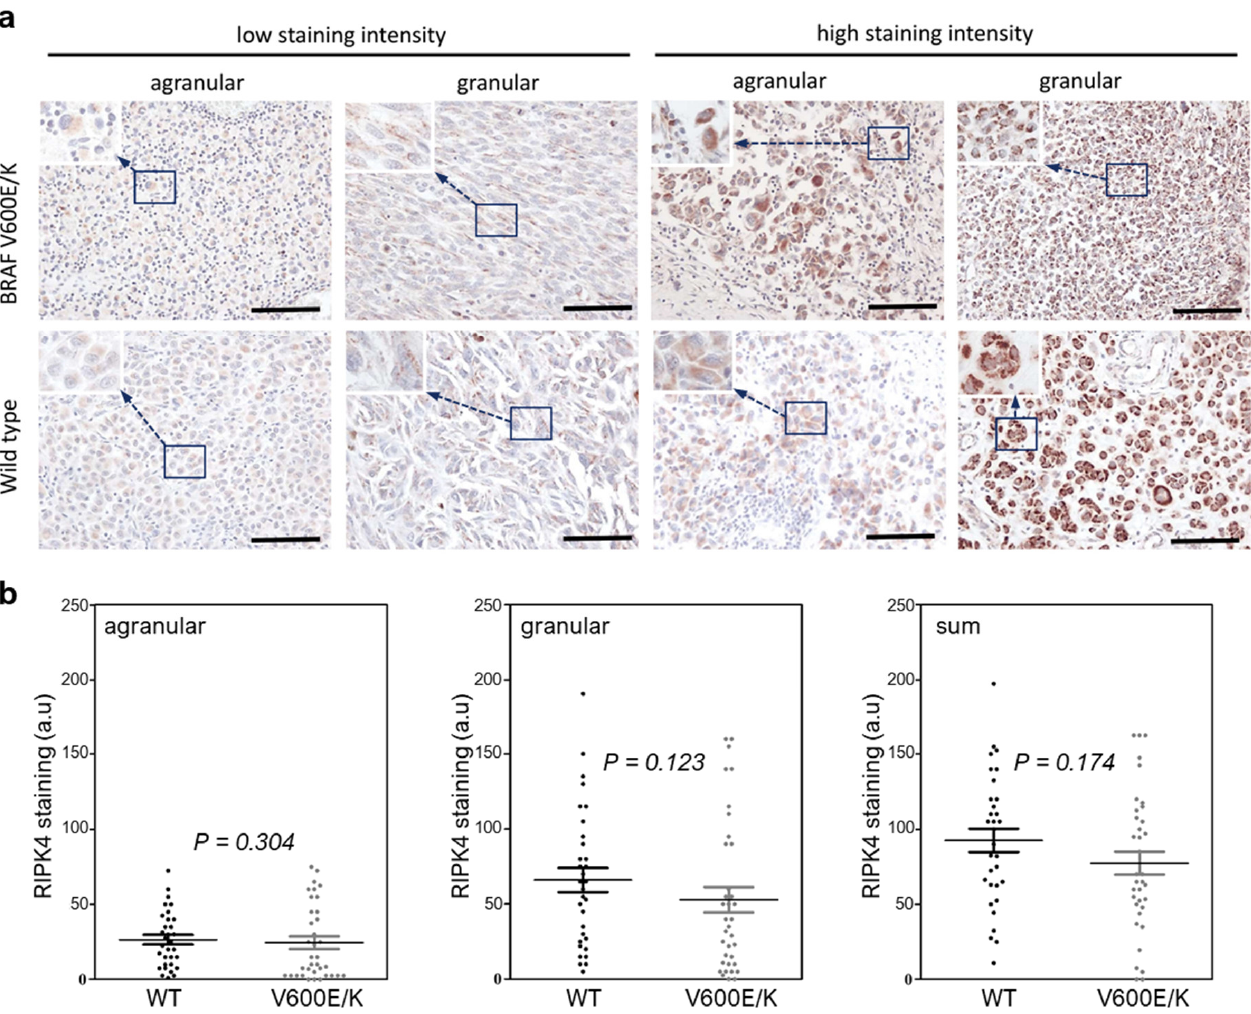
Figure 2. The BRAF mutation does not affect RIPK4 expression in metastatic melanoma. ( a ) Ex- pression of RIPK4 in wild-type and BRAF V600E metastatic melanomas with low and high (agranular and granular stain pattern). Original magnification: 400x, scale bar = 100 µm. ( b ) Quantification of RIPK4 in melanoma specimens. The scatter plots present individual data for RIPK4 for each sample and the mean ± SD of wild-type (WT, n = 32) and ( BRAF V600E/K, n = 36). Statistical analysis of 68 specimens using the Mann–Whitney rank sum test, as indicated.